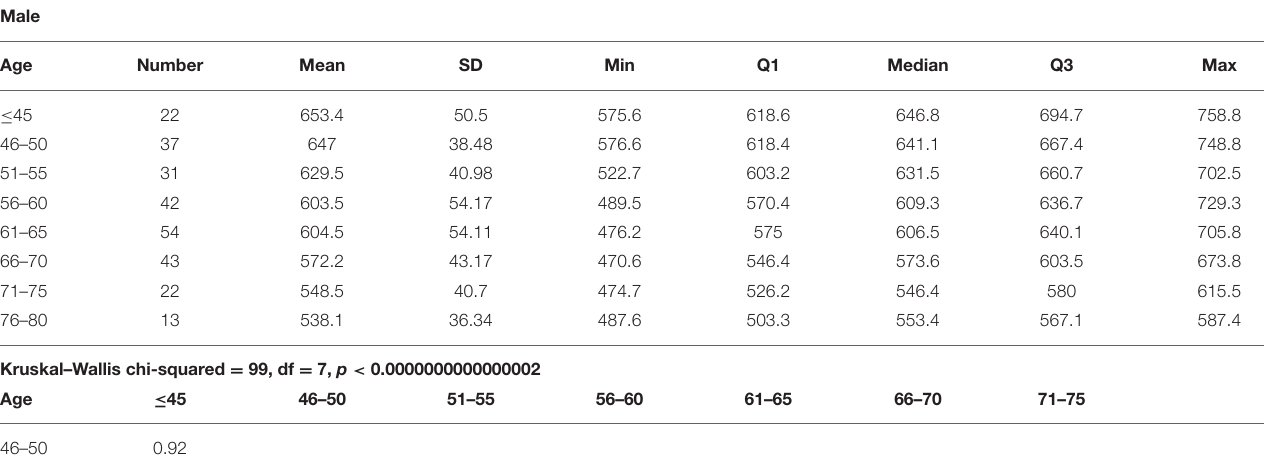
TABLE 2 | The results of total gray matter measurements in different age groups and comparisons of the gray matter volumes among the age groups separately in men and women. Gray matter